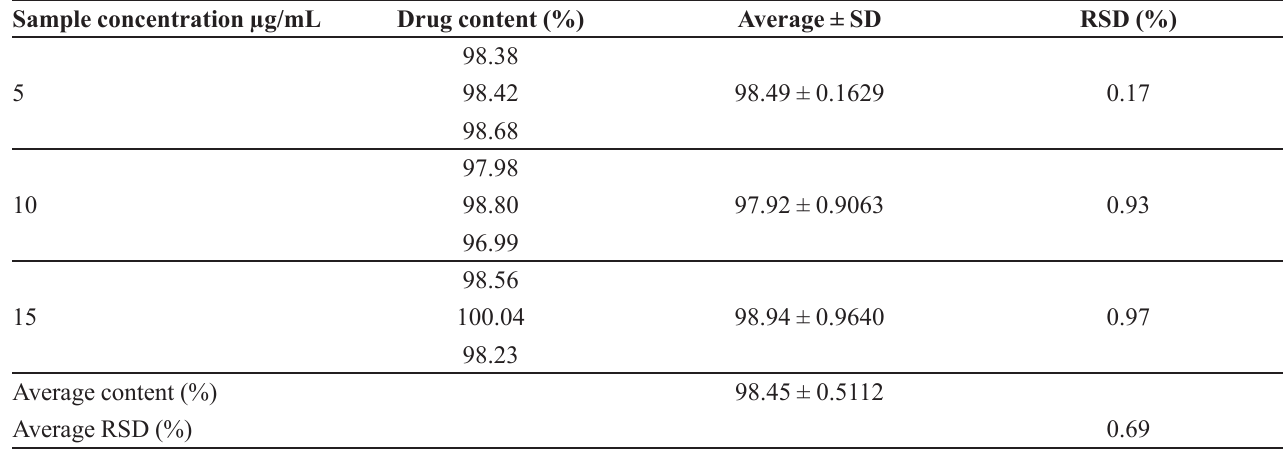
RSD – relative standard deviation. SD – standard deviation. TABLE III - Values obtained for the repeatability determination for MUP-loaded polymeric nanocapsules with rosemary oil Sample concentration µg/mL